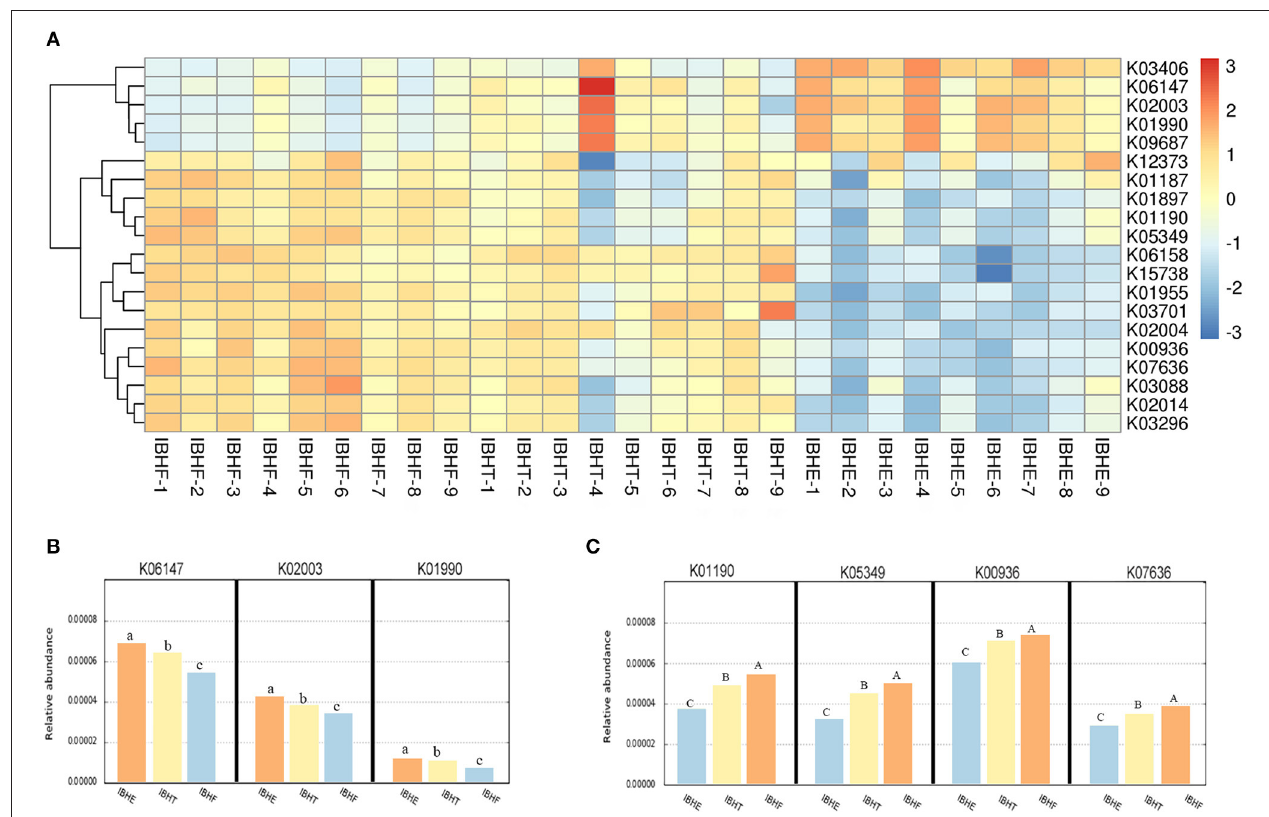
FIGURE 6 | (A) The heatmap of functional prediction of Kyoto Encyclopedia of Genes and Genomes (KEGG) Orthology (KO) of operational taxonomic units (OTUs) in different growth periods. The color gradient of heatmap was from red to yellow to blue, which indicates that the KO abundance predicted by OTU in each sample decreased gradually. The redder the color, the more bacteria performed this function. The bluer the color, the lesser bacteria performed this function. IBHE, IBHT, and IBHF refer to “ISA Brown Hens-8 weeks,” “ISA Brown Hens-20 weeks,” and “ISA Brown Hens-50 weeks,” respectively. (B) The abundance histograms of significantly reduced KO of OTUs from 8 to 20 and 50 weeks. (C) The abundance histograms of significantly increased KO of OTUs from 8 to 20 and 50 weeks. KO with different superscript letters means significant differences ( P < 0.05) between groups, and different superscript letters mean extremely significant differences ( P < 0.01).